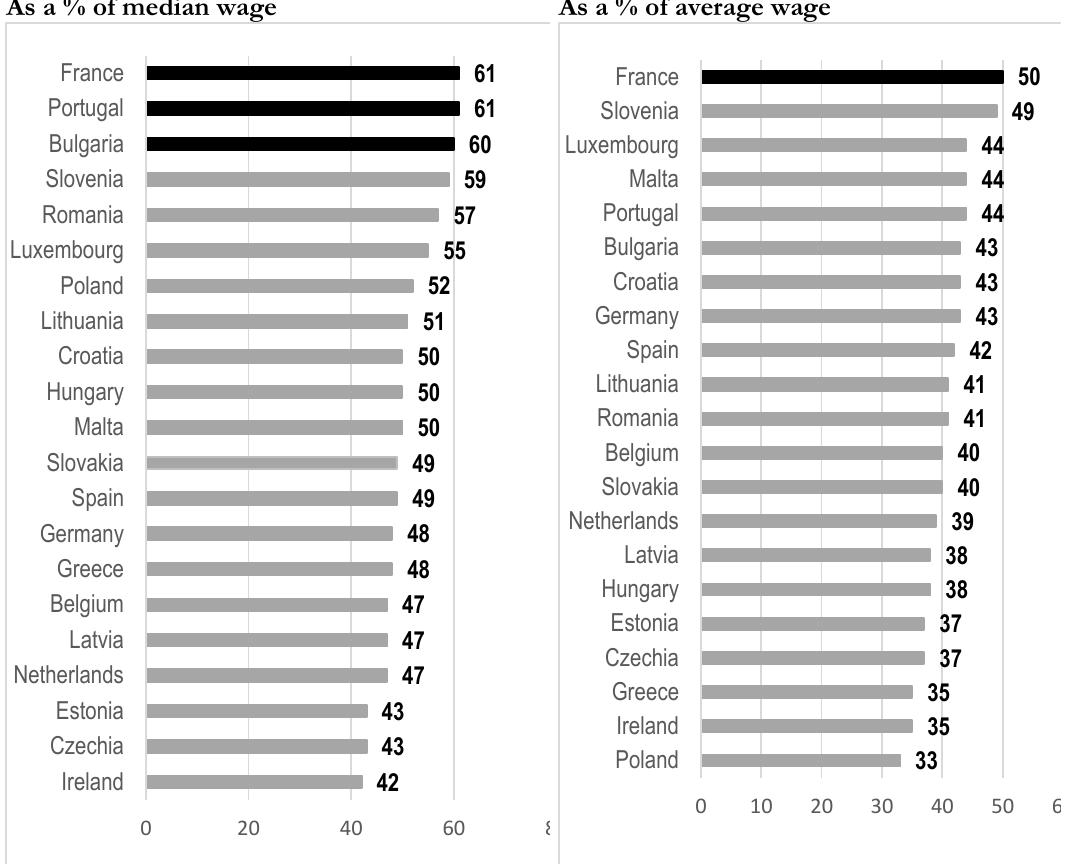
Figure 1: Minimum wages in the European Union 2019 As a percentage of national median and average wages of full-time employees As a % of median wage As a % of average